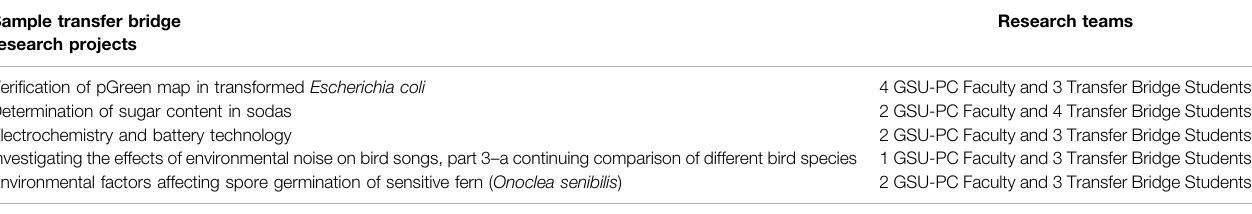
TABLE 2 | Sample GSU-PC transfer bridge research projects.